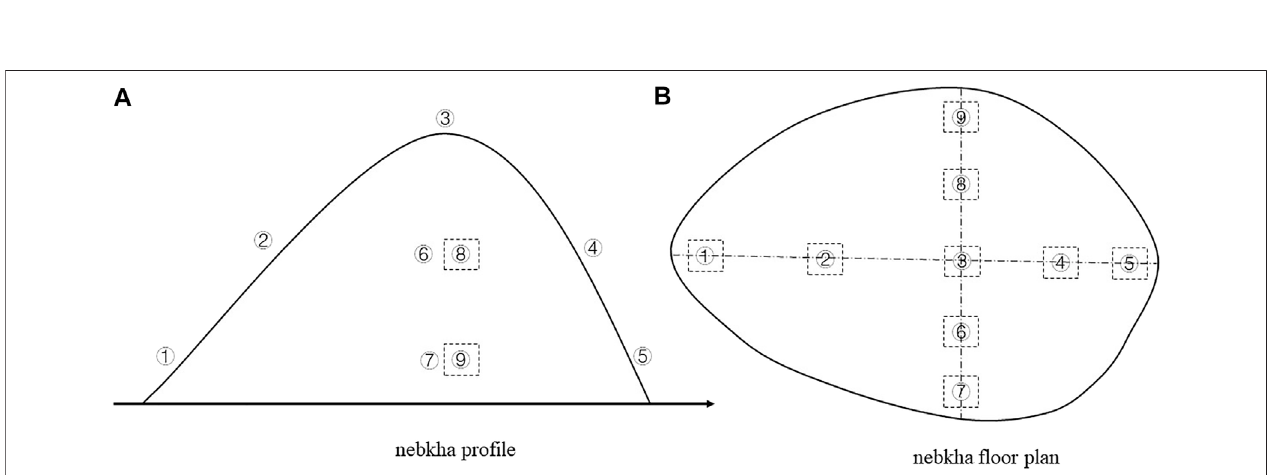
a Values are means and standard deviations in parentheses.